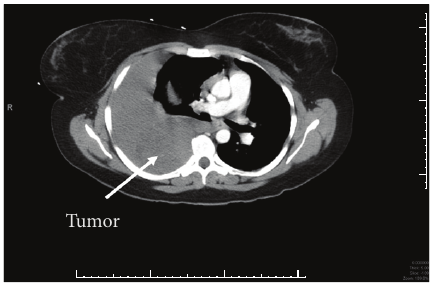
Figure 1: Outside hospital CT scan showing hemothorax and unrecognized schwannoma.